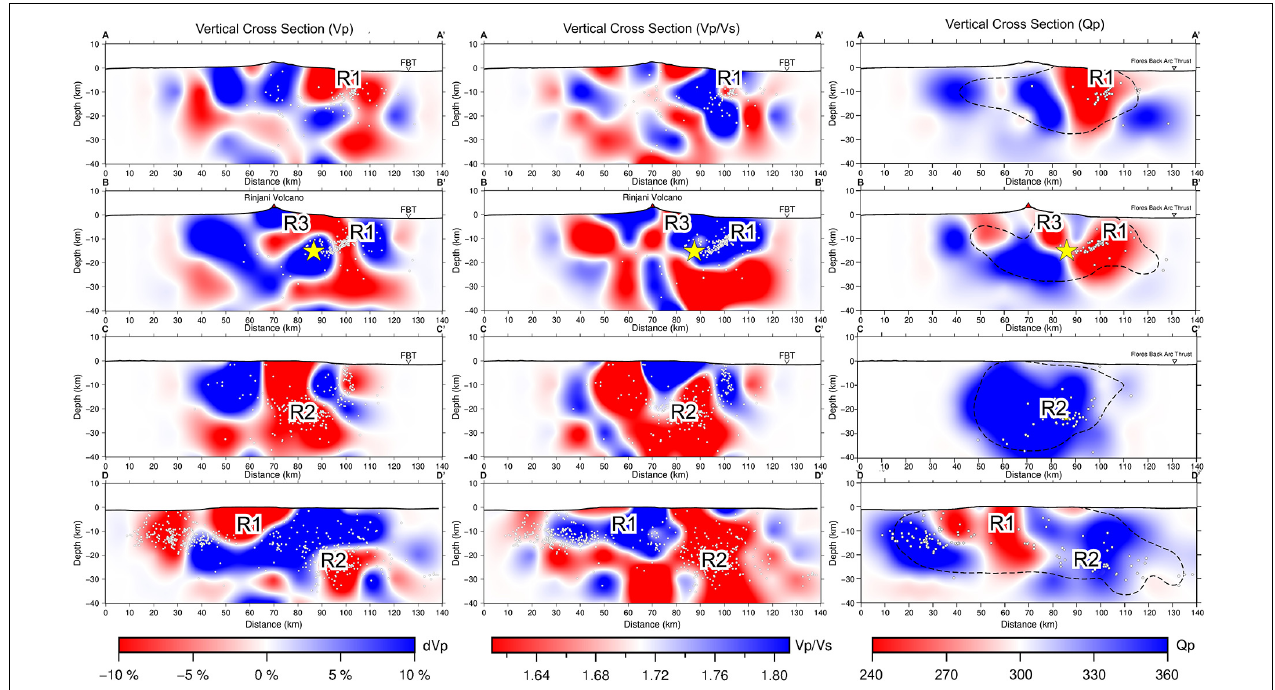
FIGURE 8 | The vertical cross-sections AA (cid:48) , BB (cid:48) , CC (cid:48) to DD (cid:48) (see Figure 3A ), which show the seismic velocity structure for V p (left column), V p / V s ratio (middle column), from Afif et al. (2020) and Q p (right column). The color bar shows the variations in V p , V p / V s , and Q p . V p plotted as percent perturbation relative to the 1D initial velocity model and V p / V s and Q p are plotted as absolute values. The blue and red colors represent higher and lower values. The black dashed line in the Q p tomogram indicates the well-resolved area based on DRE ( > 0.1). The white dots indicate the locations of hypocenters with a radius of 3 km from the centerline. The yellow stars represent the hypocenters of the significant events. The captions listing R1, R2, R3, and R4 are the regions interpreted in this